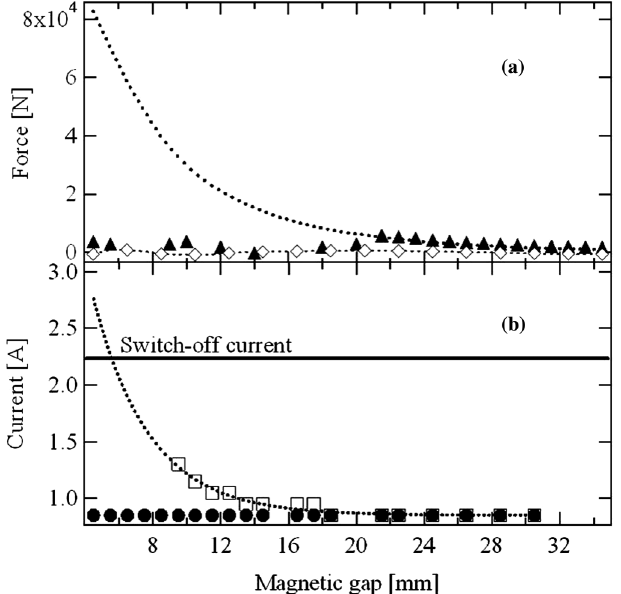
FIG. 6. In (a), calculated force acting on magnet girders with- out counterforce system ( . . . ), with magnetic counterforce sys- tem ( e ), and with spring counterforce system ( m ). In (b), measured current of motors required to move the gap with (cid:7) ) or without springs ( h ). (